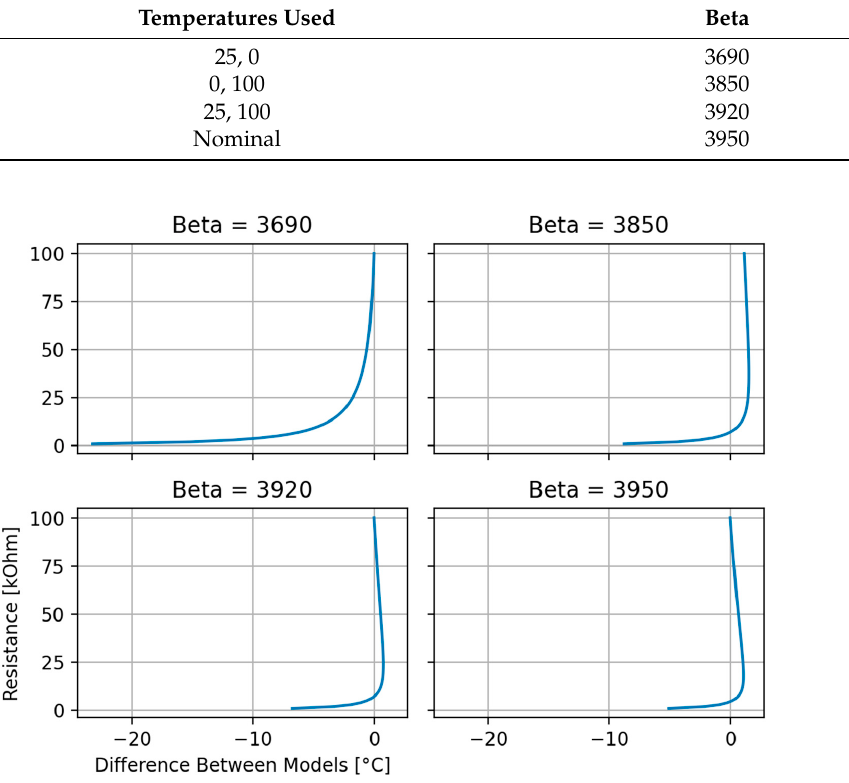
( a ) ( b ) Figure 18. Temperature gradient measurements. ( a ) Chamber loosely packed with rPET; ( b ) cham- ber loosely packed with rPET, plus a metal cylinder, referred to as a heat sink. The measured temperature gradients while using the inside (0 mm) thermistor to drive the controller are shown in Figure 19. With no material in the chamber, the heater had to maintain an average temperature of 79 °C to keep the inside surface of the chamber at 60 °C. Note that the chamber was open to atmospheric air, allowing convective heat